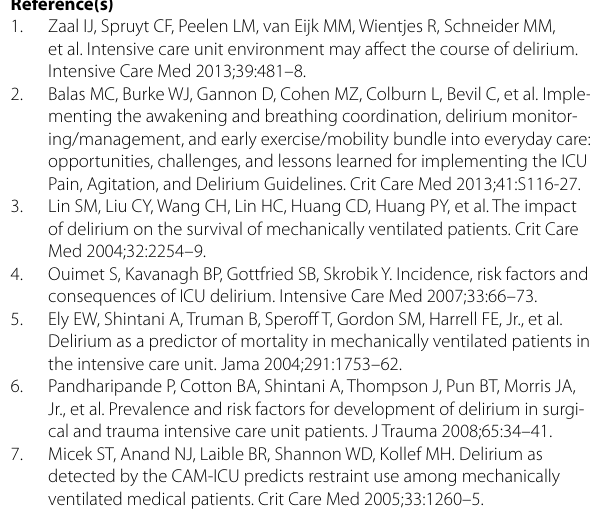
Figure 1. Cox proportional hazard model of the time to first delirium event during the intensive care unit (ICU) stay according to Window- less (room without windows) or Window (room with windows) groups Conclusion. Exposure to natural light through windows was associ- ated with a decreased risk of delirium as compared to admission to a single windowless room. Natural light exposure was also associated with a decreased risk of delirium and time to the first delirium